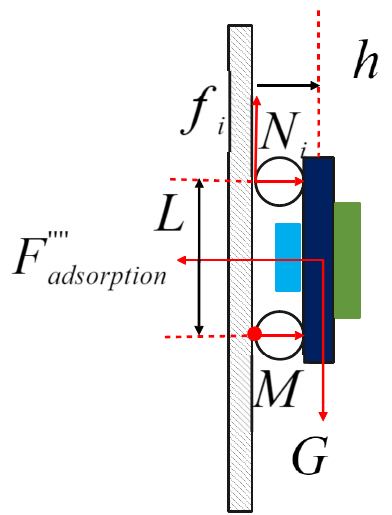
Figure 5. Schematic diagram of the static analysis under State